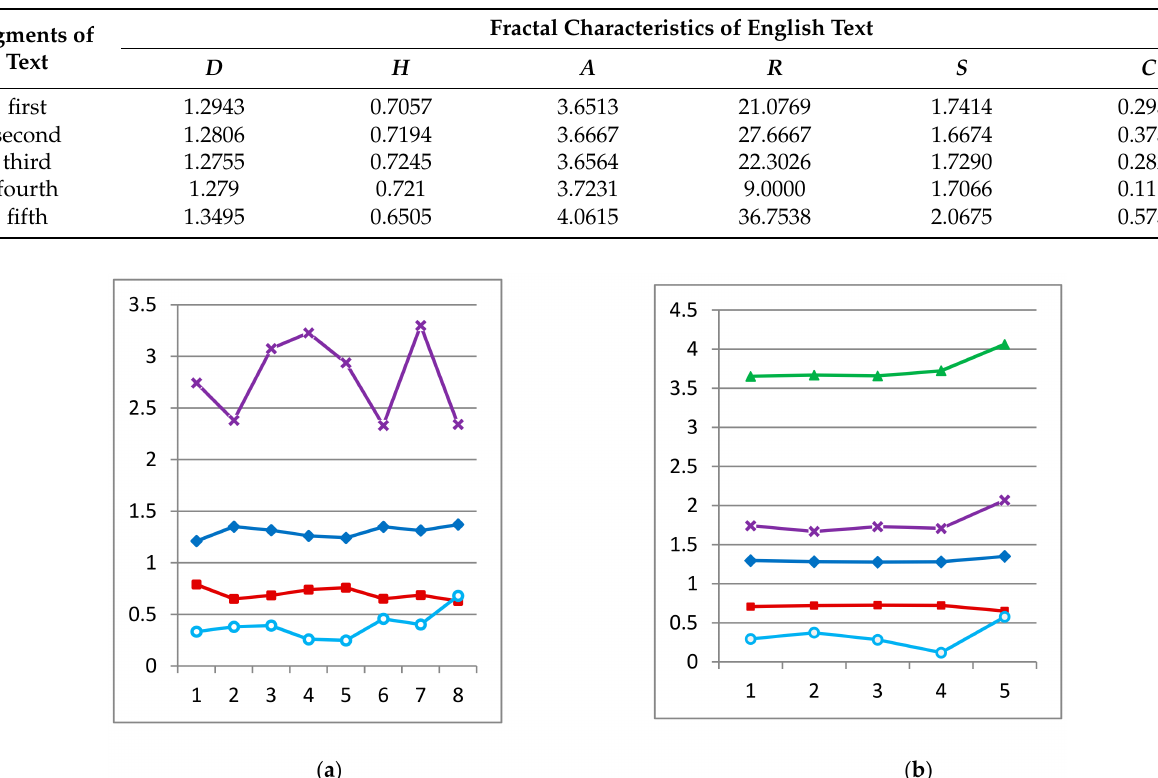
Figure 5. Visualization of the data of Tables 3 and 4 except for the indicator R. On the left the graph is the indicators for styles ( a ), and on the right for the English text ( b ). The bottom-up order is as follows: constant, Hurst index, fractal dimension, standard deviation, and arithmetic mean.